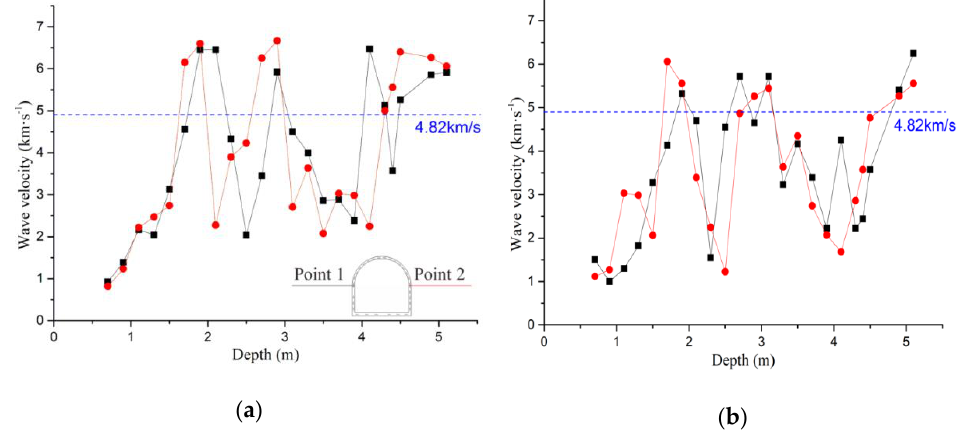
Figure 10. Longitudinal wave velocity curves in Section 1. ( a ) Measurement points on the spring line. ( b ) Measurement points on the spandrel.